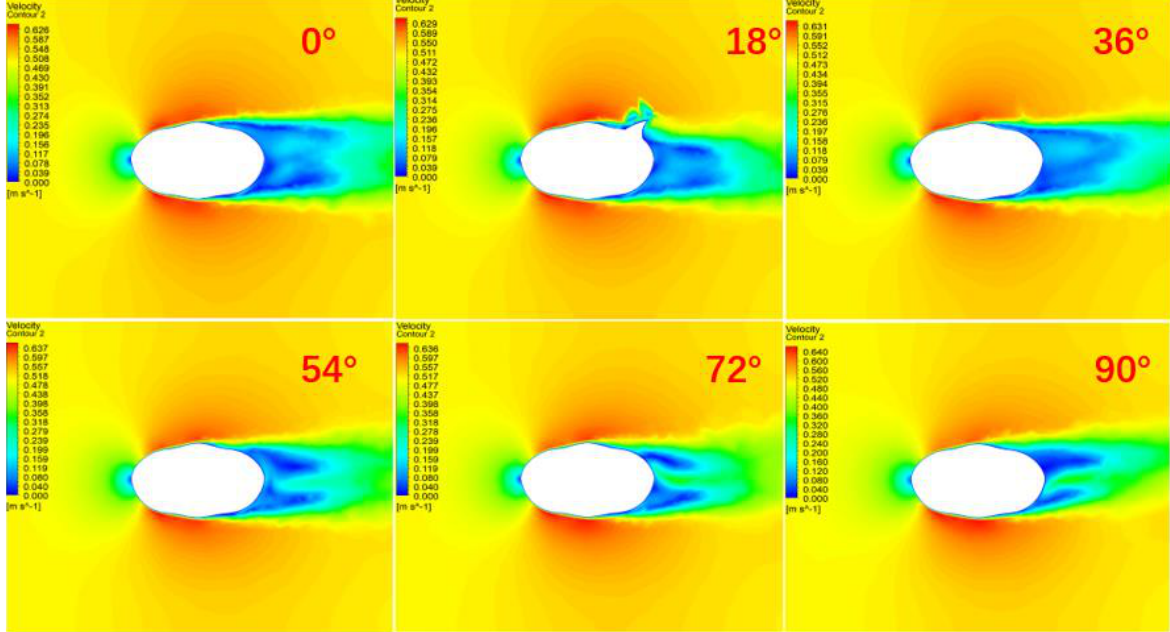
Figure 3. Pressure contour of the shell with fins at different angles. As the angle is rotated, the pres- sure on the shell’s circumference does not change; pressure on fins increases gradually and reaches a maximum at 72 degrees.